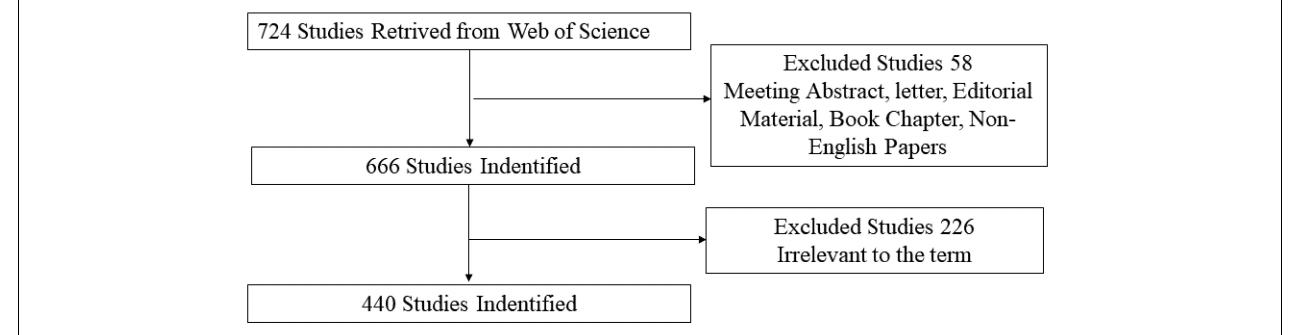
FIGURE 1 | Flow chart of studies inclusion.